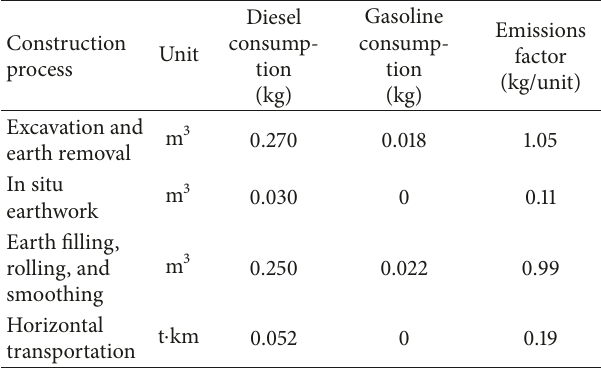
Table 5: CO emission factors for different construction 2